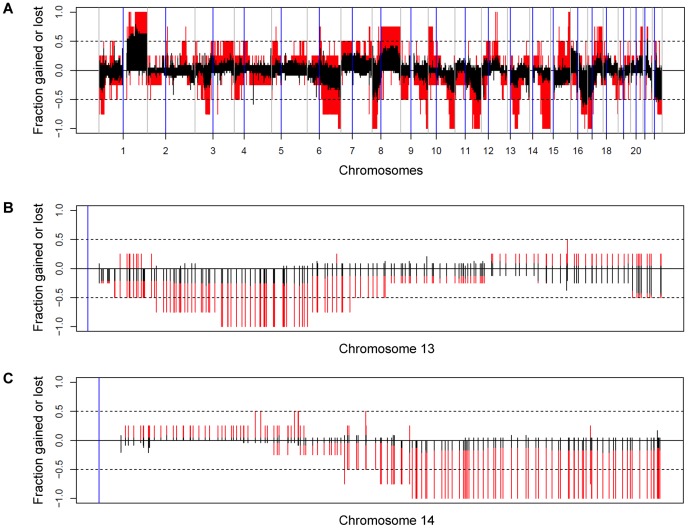
Cumulative rates of gain and loss for tumors analyzed by CGH (red, 4 BRCA2-mutant tumors; black, 24 BRCAX tumors).A, All chromosomes; B, Chromosome 13; C, Chromosome 14. Each vertical line in B & C corresponds to an individual BAC probe. When the red line reaches −1, all of the tumors showed loss for that probe.